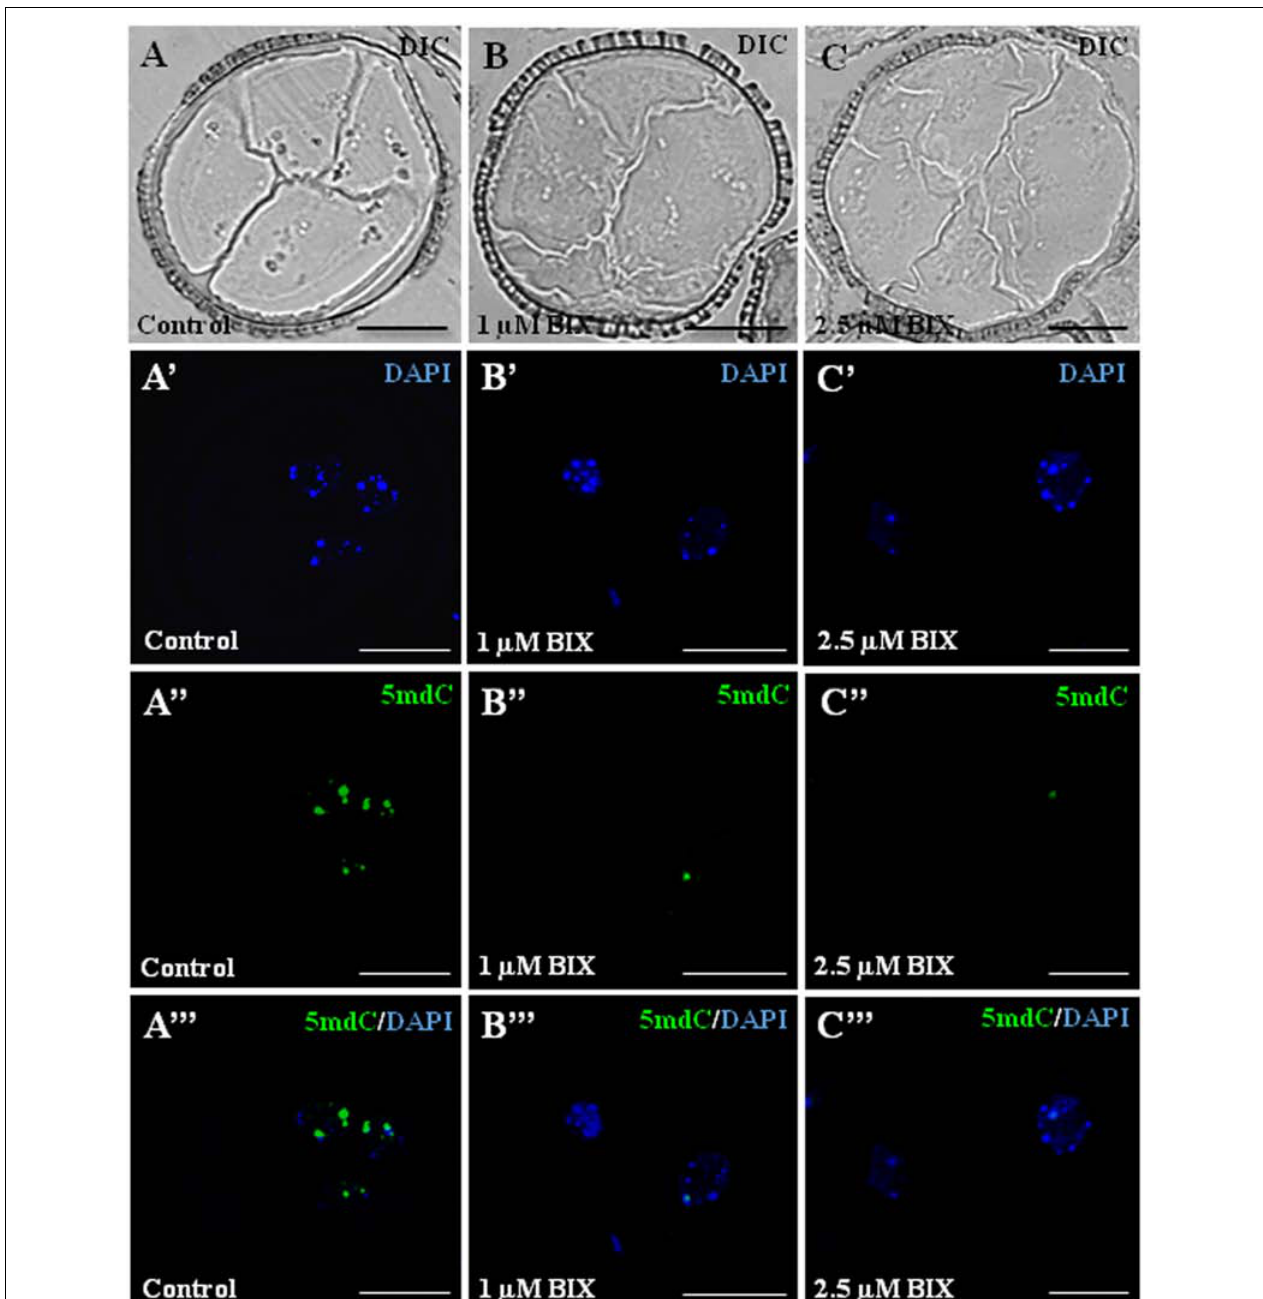
FIGURE 12 | Distribution patterns of methylated DNA (5mdC) in microspore proembryos formed in control conditions and short BIX-01294 treatments. 5mdC immunofluorescence and confocal laser scanning microscopy analysis in Brassica napus . Microspore proembryos of control (A–A”’) , 1 µ M (B–B”’) and 2.5 µ M (C–C”’) BIX-01294 treated cultures. (A–C) : Nomarsky’s differential interference contrast (DIC) images of the proembryo structure. (A’–C’) : DAPI staining of nuclei (blue). (A”–C”) : 5mdC immunofluorescence signal (green). (A”’–C”’) : Merged images of DAPI (blue) and 5mdC immunofluorescence (green). The same structures are visualized under different microscopy modes in (A–A”’) , (B–B”’) and (C–C”’) . Bars represent 20 µ